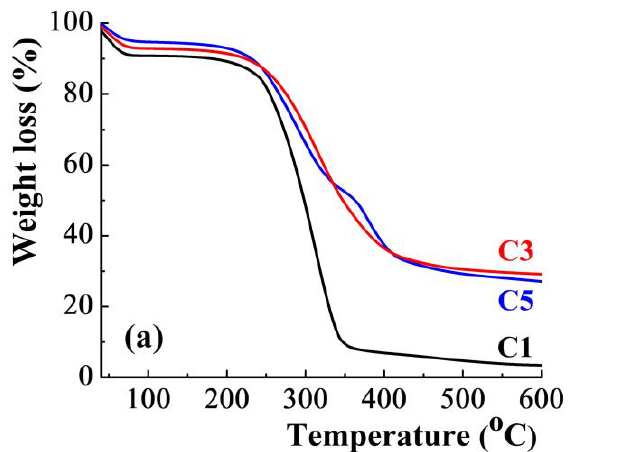
Figure 6. EDX analysis of samples ( a ) C1 and ( b ) C5.